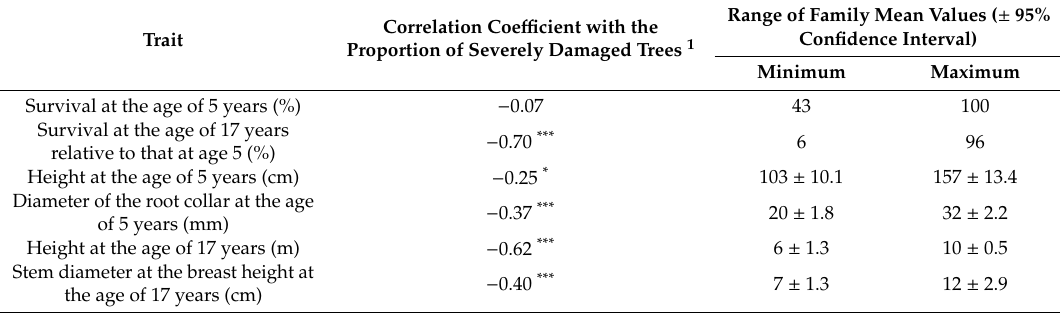
Table 1. Survival, tree dimensions, and correlation coe ffi cients between these traits and the proportion of severely damaged trees (pooled grades 4 and 5) at the family mean